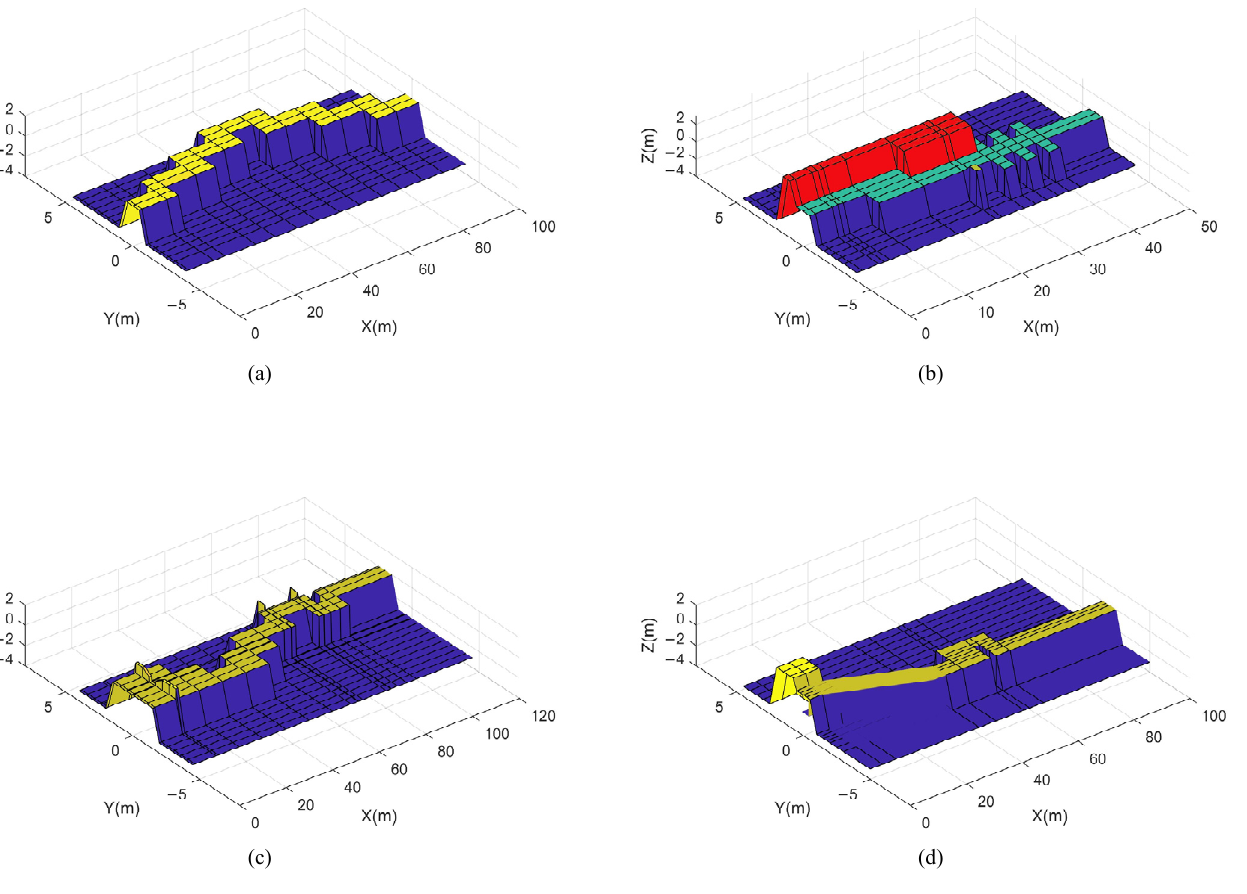
Figure 10. Test terrain used for validation: ( a ) test terrain 1; ( b ) test terrain 2; ( c ) test terrain 3; ( d ) test terrain 4.